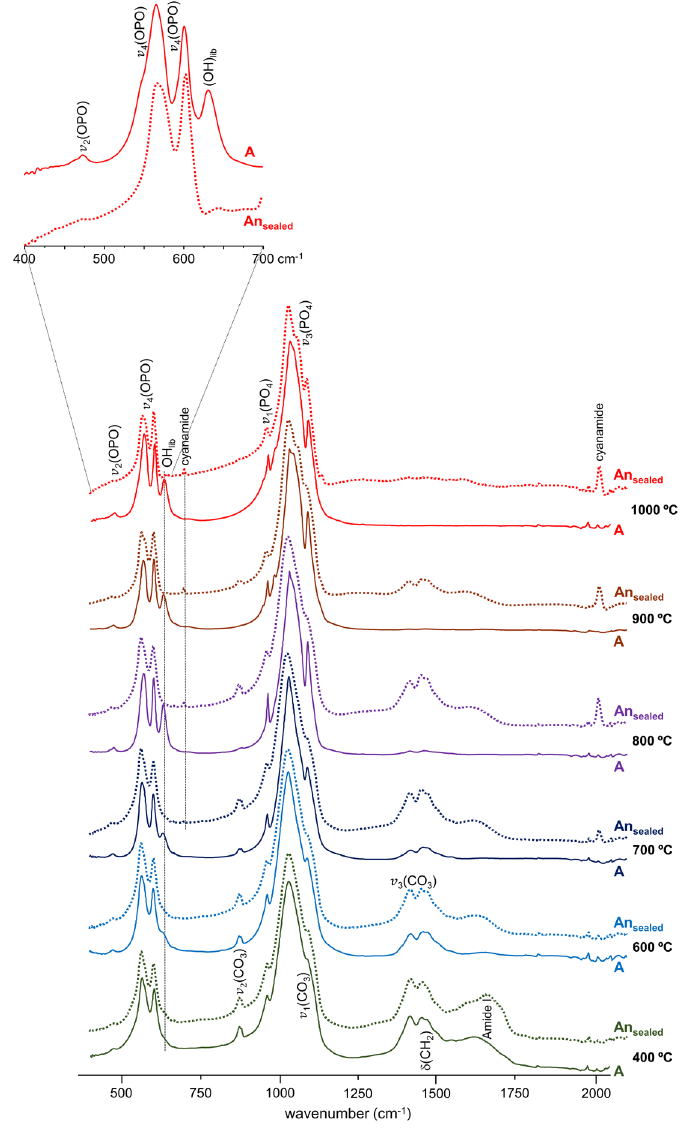
Figure 5. FTIR-ATR spectra (400–2000 cm −1 ) of human humerus burned at different temperatures (400 to 1000 ° °C) either under aerobic ( A ) or anaerobic/sealed (An sealed ) conditions. The insert shows a magnification of the phosphate and OH librational bands from